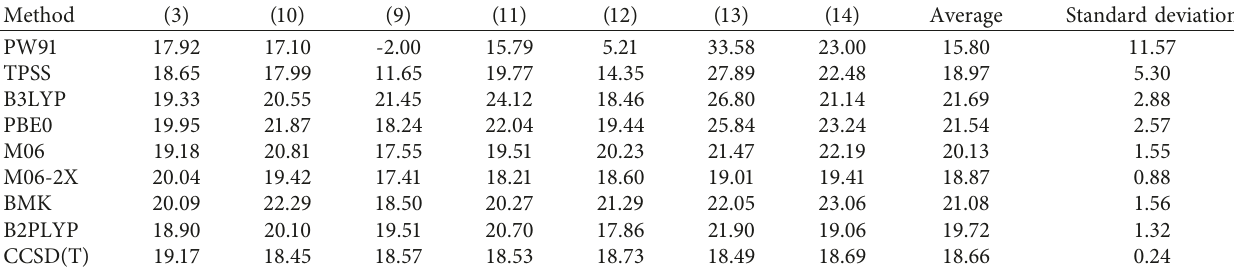
Table 6: Enthalpies of formation of ClOCl (in kcal/mol) obtained from reactions (3) and (9)–(14) using the indicated method and the aug- cc-pV6Z basis set. The average value of those obtained for all the reactions and the standard deviation are shown in the last two columns of the table.